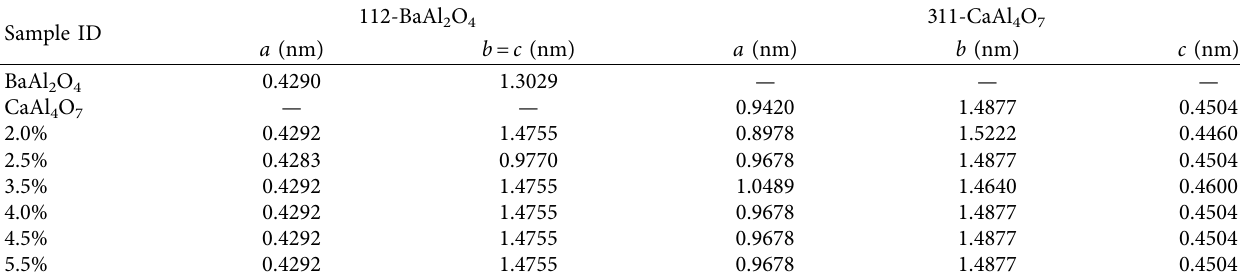
Table 1: Summary of the samples identification and lattice